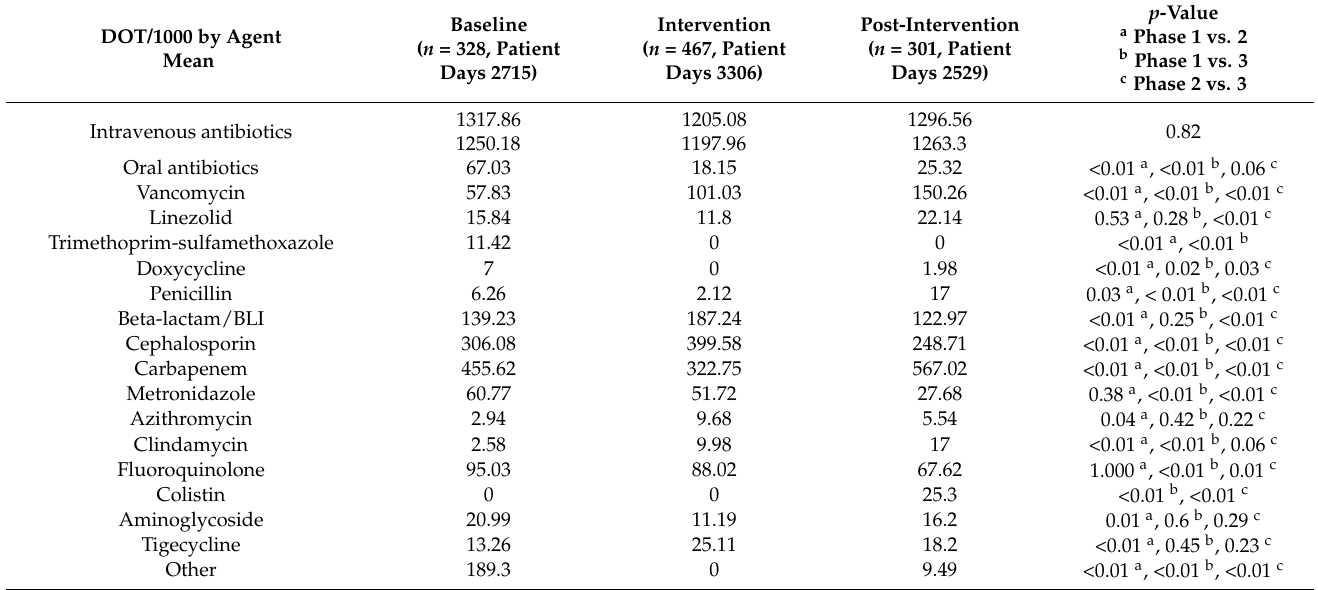
Table 3. Antibiotic agent used in each